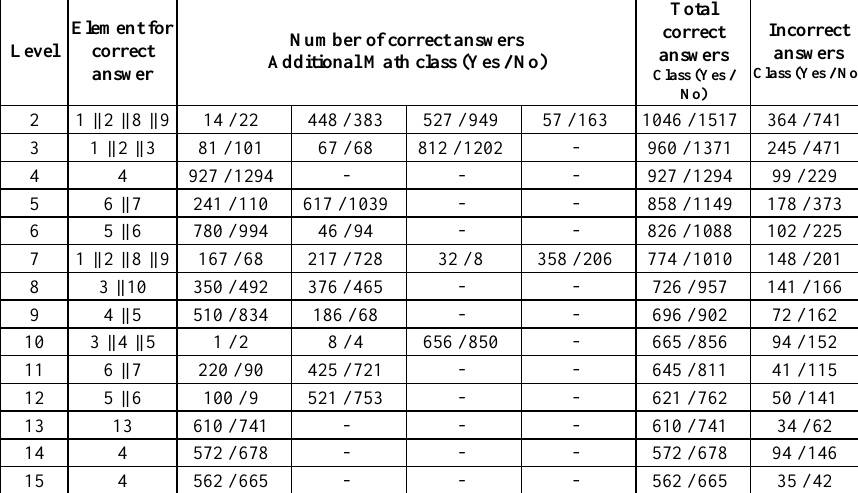
Table 5. Elements used in finishing levels in the game “Zagonetke mudrog lisca” differentiated by whether the student takes additional classes in Mathematics Element for Level